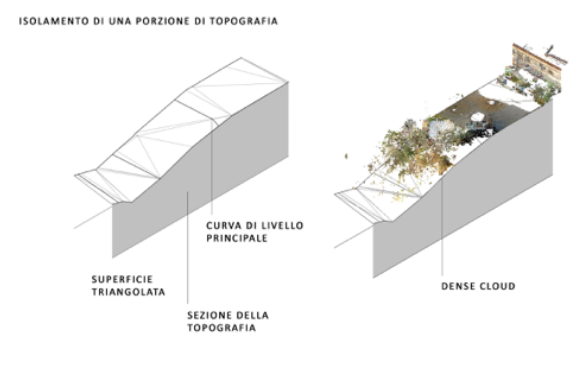
Figure 4: Model developed in the LIM field, within the Autodesk Revit 2019 software. The topography has been modeled by assigning the elevation points of the surface to the detected points of the dense cloud. In this way the terrain model works as a covering element of the dense cloud, replacing its